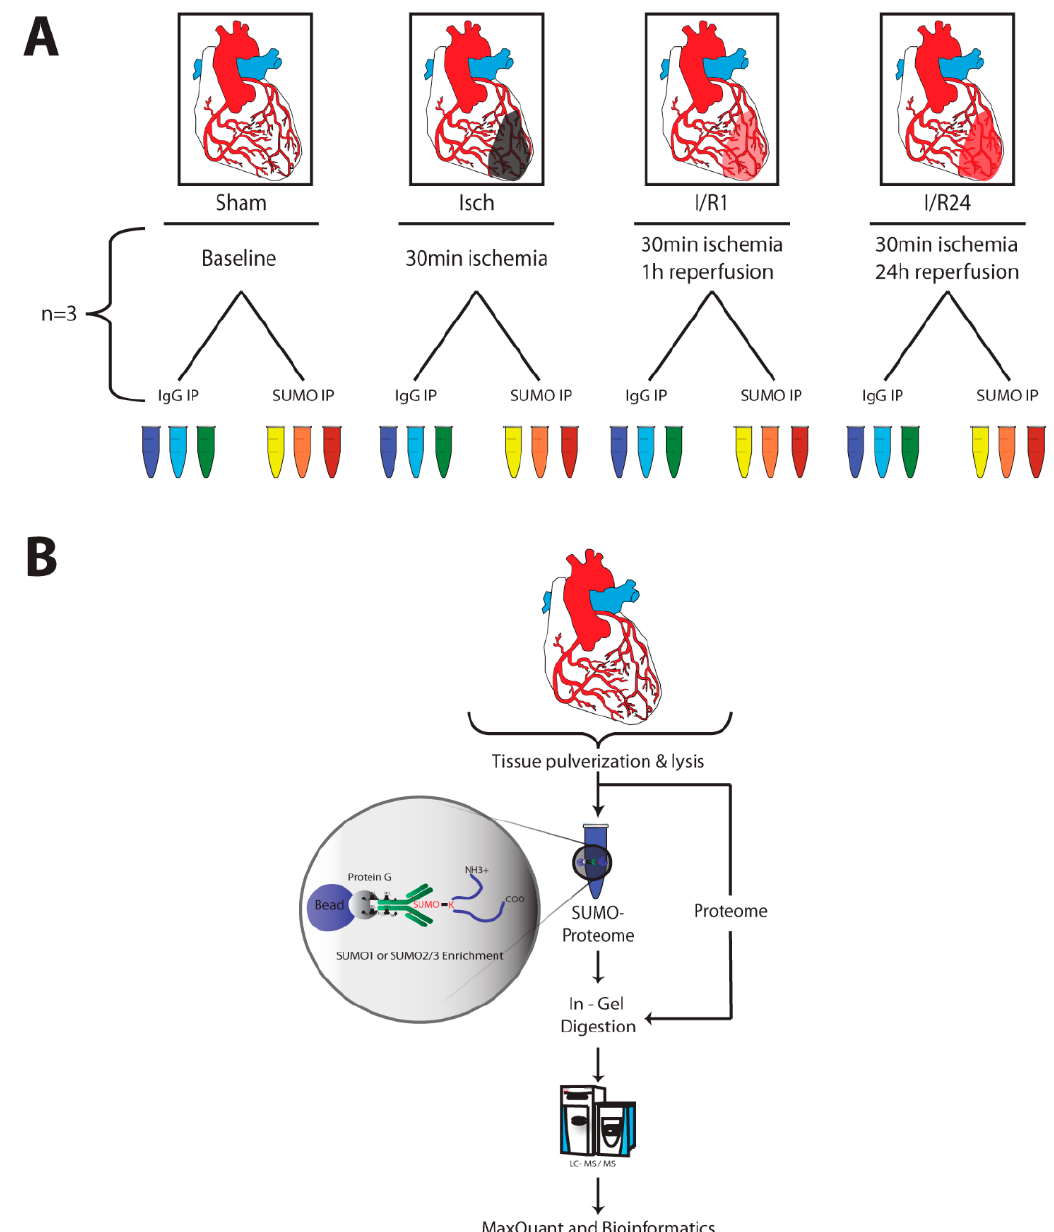
Figure 2. Experimental Setup and workflow of SUMO immunoprecipitation and mass spectrometry. ( A ) Experimental Setup. Mice underwent cardiac surgery in order to ligate left anterior descending artery for 30 min (Isch) and re-open it again for 1 h (I / R1) or 24 h (I / R24) reperfusion. Four mouse hearts for each condition (Sham, Isch, I / R1 or I / R24) were pooled as one biological replicate. The same replicate was used for both SUMO and IgG Control IP. All experiments were performed in triplicates. ( B ) Experimental Workflow of SUMO immunoprecipitation and mass spectrometry. Mouse hearts were snap frozen and pulverized in liquid nitrogen. Powder was lysed in 1% SDS bu ff er and homogenized in a ball mill. IPs were performed using in-house produced SUMO1-, SUMO2 / 3- or IgG antibody coupled beads. An aliquot of IP input was used for proteome analysis. IP Eluates representing SUMO1 or SUMO2 / 3 proteome were separated by SDS-PAGE and subjected to in-gel digestion protocol using trypsin. Peptides were analyzed by a streamlined in-house LC-MS / MS Bioinformatics